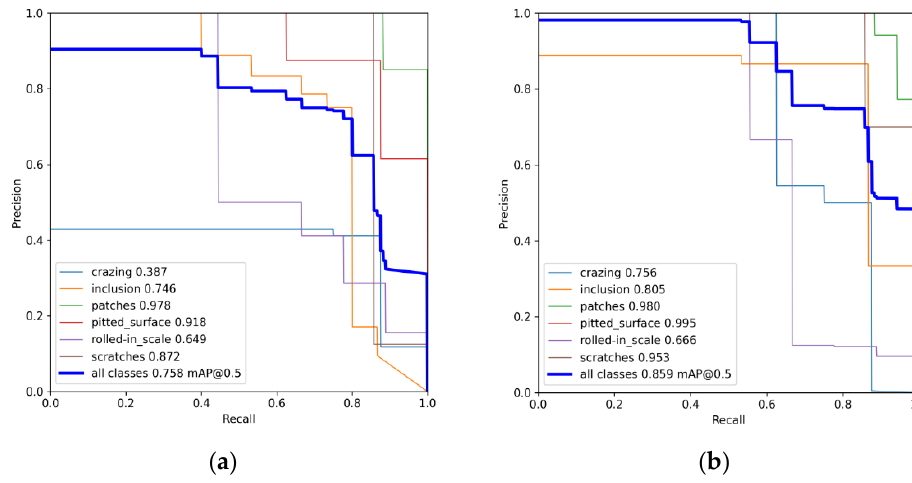
Figure 11. PR Curve: ( a ) YOLOV5; ( b ) Improved YOLOV5.